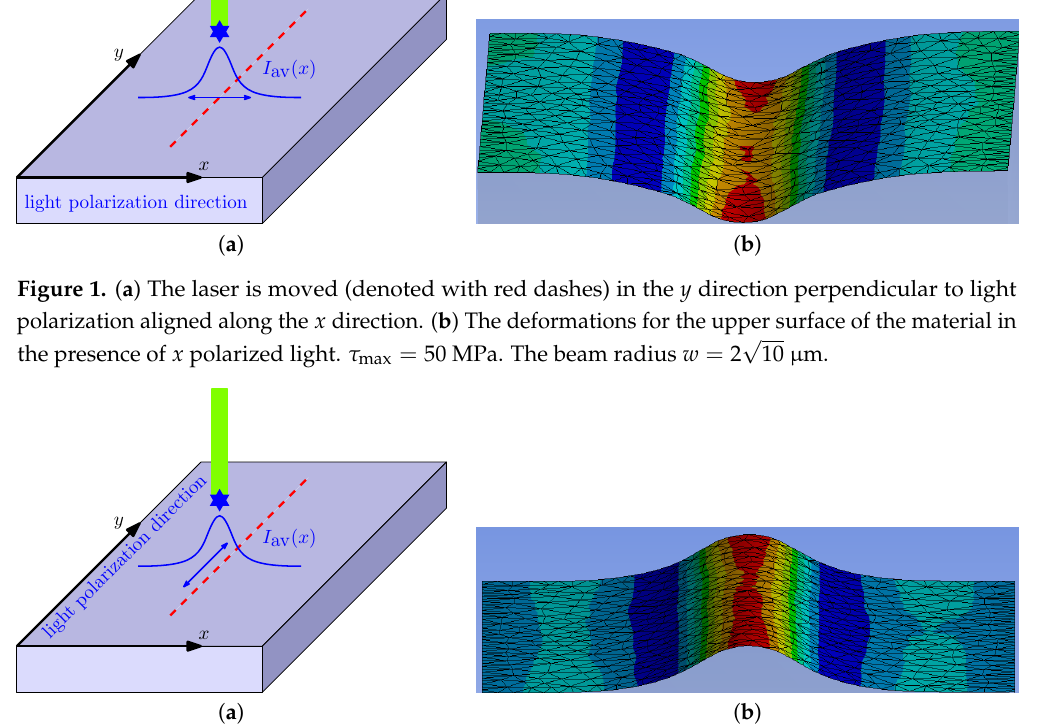
Figure 2. ( a ) The laser is moved (denoted with red dashes) in the y direction parallel to light polarization aligned along the y direction. ( b ) The deformations for the upper surface of the material in the presence of y polarized light. τ max = 50 MPa. The beam radius w = 2